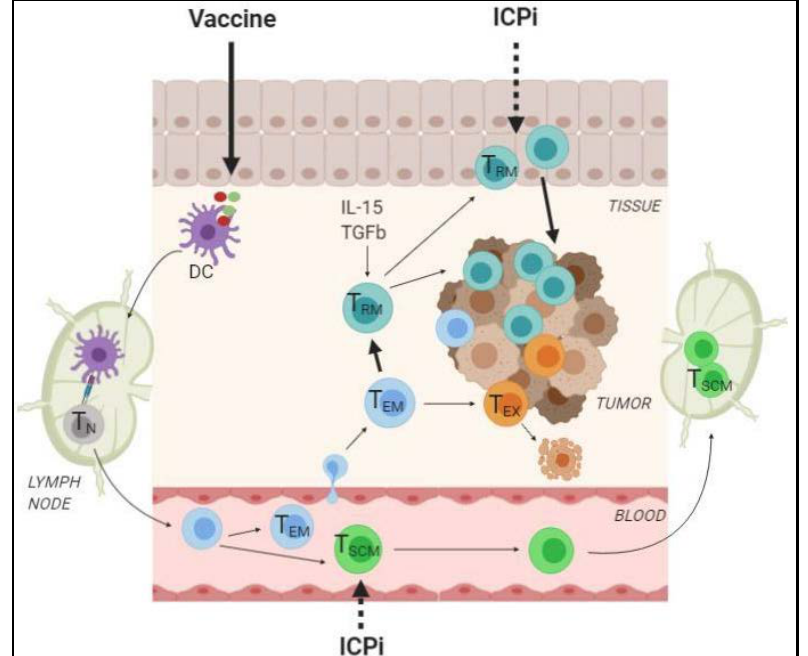
Figure 4. Proposed model of the synergistic antitumor effect of ICPi therapy combined with vaccines. Administration of vaccine by mucosal or skin route can promote the induction and expansion of T SCM and T RM cells, two memory T cell subsets providing long-term protective antitumor immunity through their self-renewal property and immediate e ff ector functions, respectively. In this model, ICPi would primarily act by favoring the recruitment of novel T RM and T SCM clonotypes into the tumor rather than reinvigorating pre-existing dysfunctional T cells. T N , naïve T cell; T SCM , stem-cell like memory T cells; T EM , e ff ector memory T cell; T RM , resident-memory T cells; T EX , exhausted / dysfunctional T cell; DC, dendritic cell.